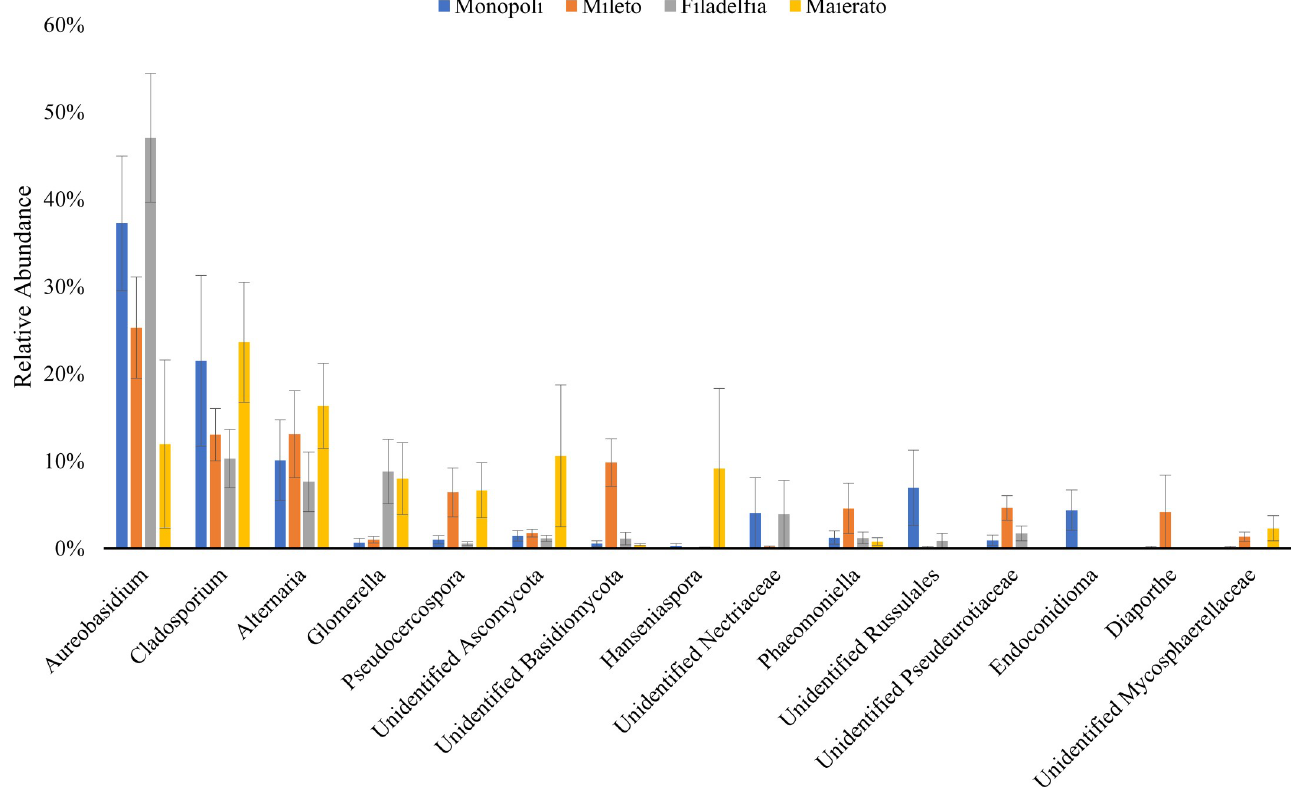
Fig 2. Relative abundances of the dominant fungal genera (RA � 1%) detected in infested and non-infested olives in Monopoli, Mileto, Filadelfia, and Maierato. Values are average of the taxa relative abundance ± the standard error.